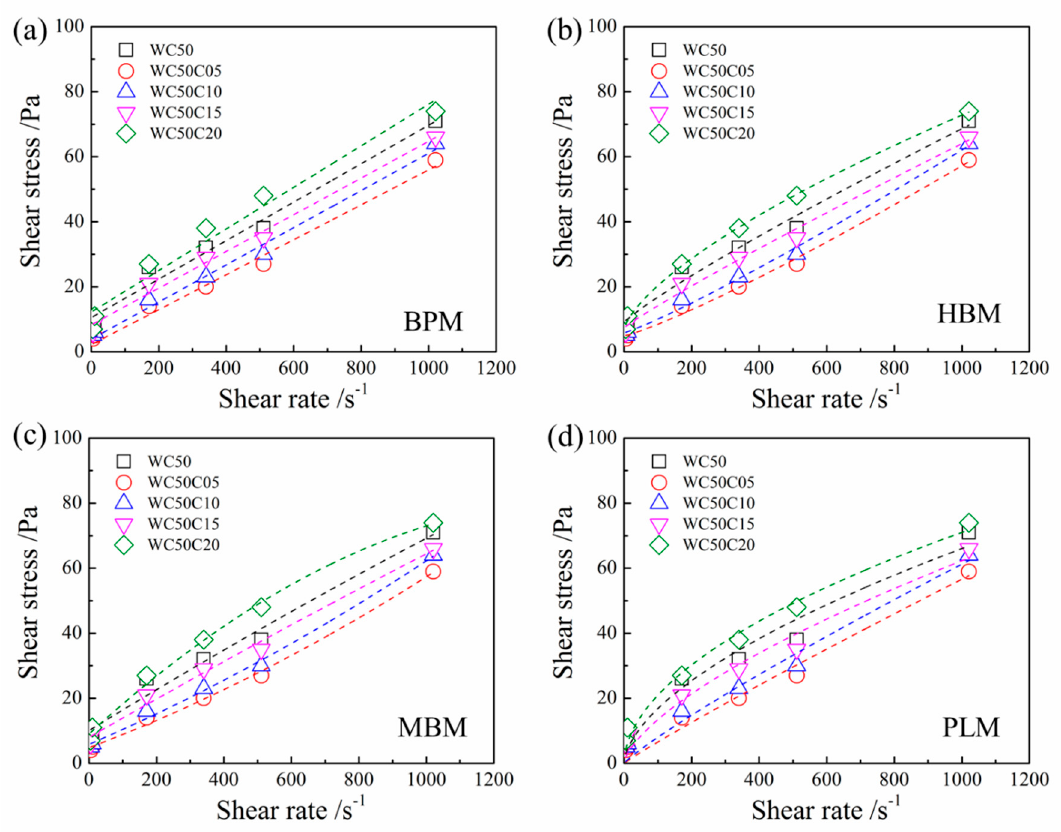
Figure 4. Experimental data and fitted plot of shear stress versus shear rate for CNC-OWC slurries: ( a ) Bingham Plastic Model; ( b ) Hershcel-Bulkley Model; ( c ) Modified Bingham Model; and ( d ) Power Law Model.